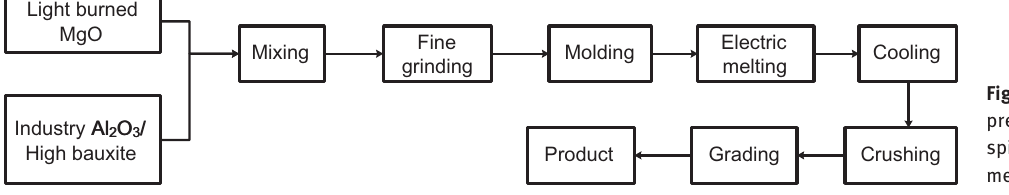
Figure 2: Flowchart of the preparation of MgAl 2 O 4 spinel by the electric- melting process.